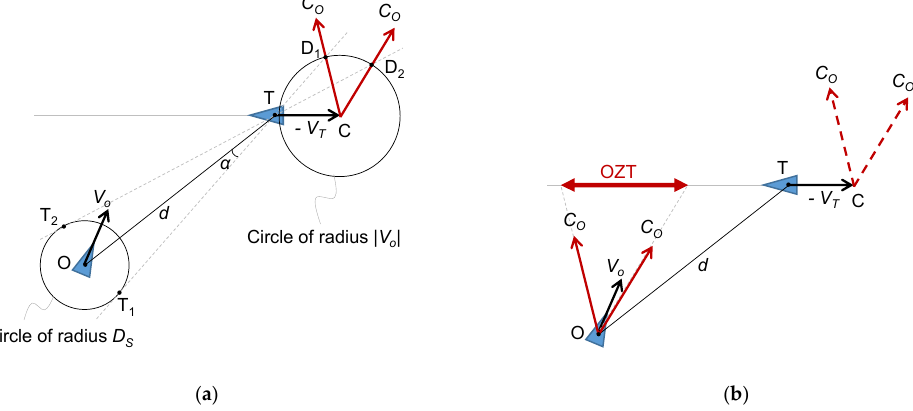
Figure 3. Method of obtaining OZT in geometric: ( a ) Collision courses. ( b ) OZT. Plotted from the explanation in [28,29].